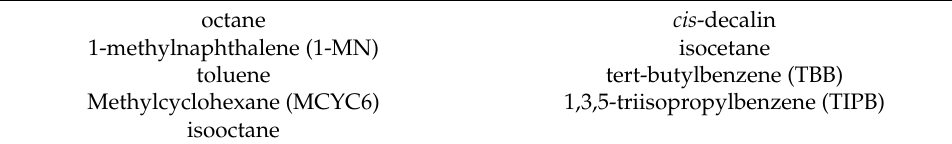
Table 1. List of nine hydrocarbon components and their acronyms.